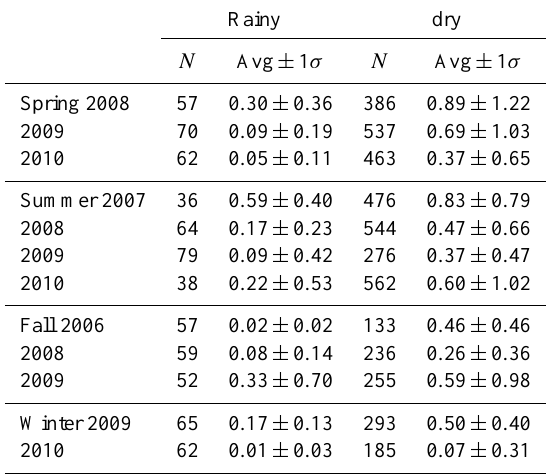
Table 3. Seasonal mean (denoted as avg) ± 1 σ values (ppqv) of RGM at Appledore Island for rainy and dry conditions. N stands for the number of samples.